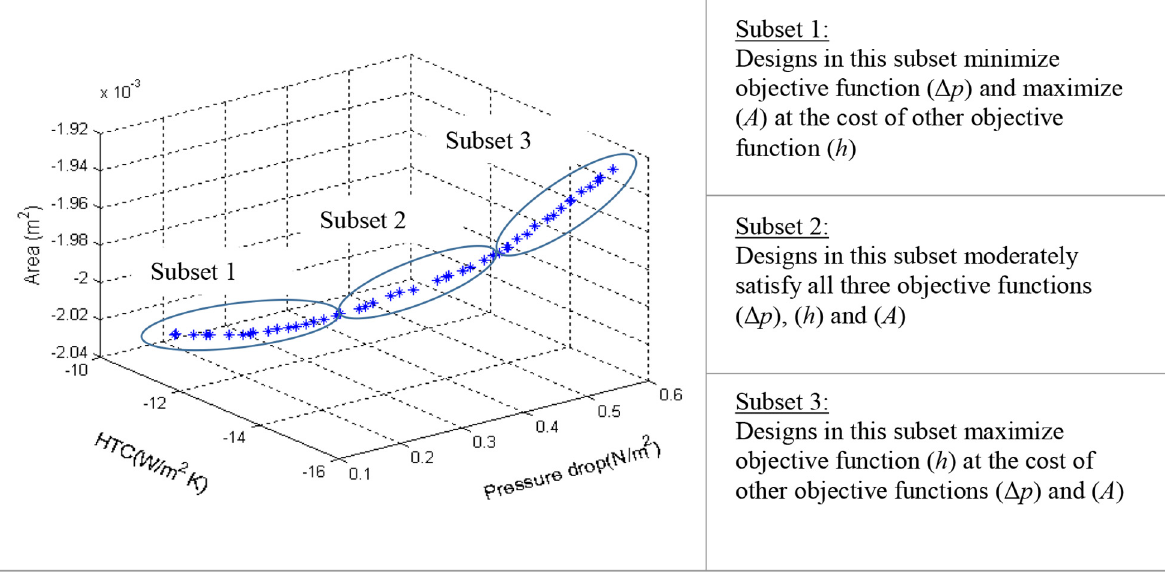
Fig. 12. Pareto optimal solution front separated into three subsets (clusters) of